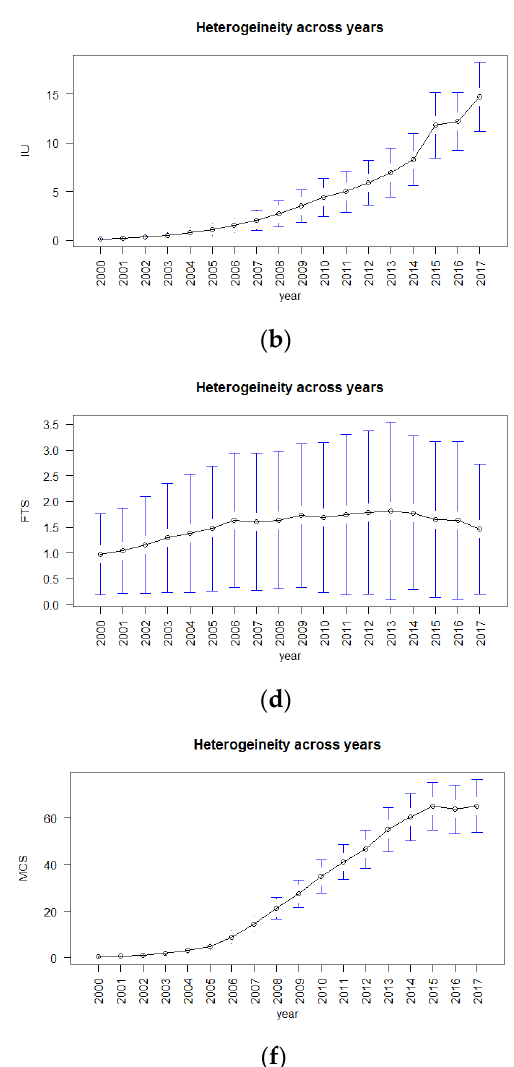
Figure 2f. Figure 2a,c,e also show that the average user, for all ICT indicators, per year, differed from country to country, especially for IU and MCS.